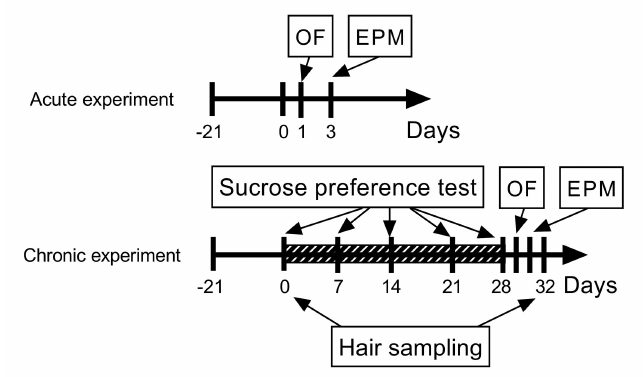
Figure 1. Study timeline to illustrate the design of the acute and chronic experiments, the application of the chronic unpredictable mild stress (CUMS) protocol, and the timing of the behavioral assays and hair sampling. The diagonally striped box shows the 28-day stressing period preceded by a 21-day habituation to single housing. Stressors were applied twice daily starting at 10:00 and 17:00. Cannabidiol was administered in a single dose of 10 mg / kg by intraperitoneal injections in the acute experiment and daily, starting at day 0 until day 32, in the chronic experiment. Abbreviations: OF, open field test; EPM, elevated plus maze